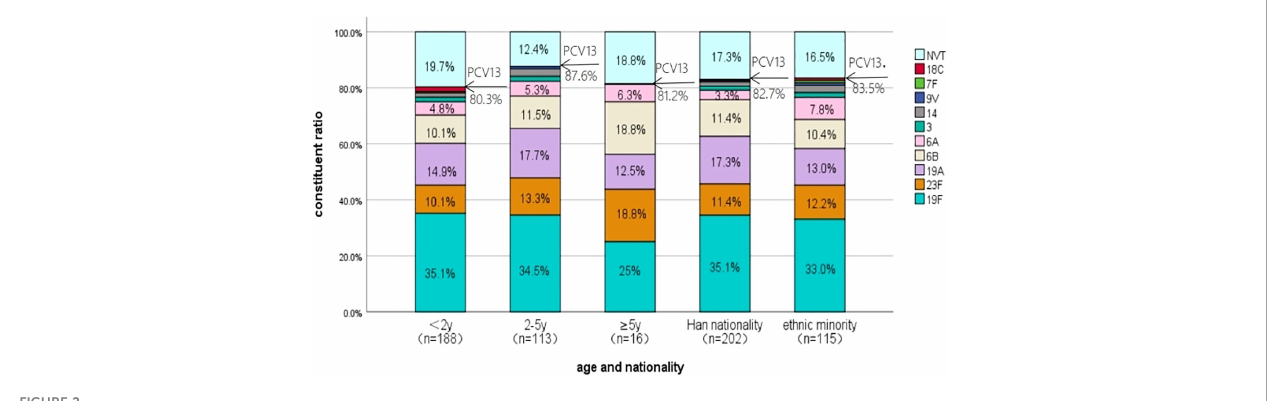
FIGURE 2 The serotype distribution of S. pneumoniae isolated from children in different age groups and different ethnic peoples in Urumqi Children ’ s Hospital during 2014-2021". The note of Figure 2 is " NVT represents the serotypes not covered by the